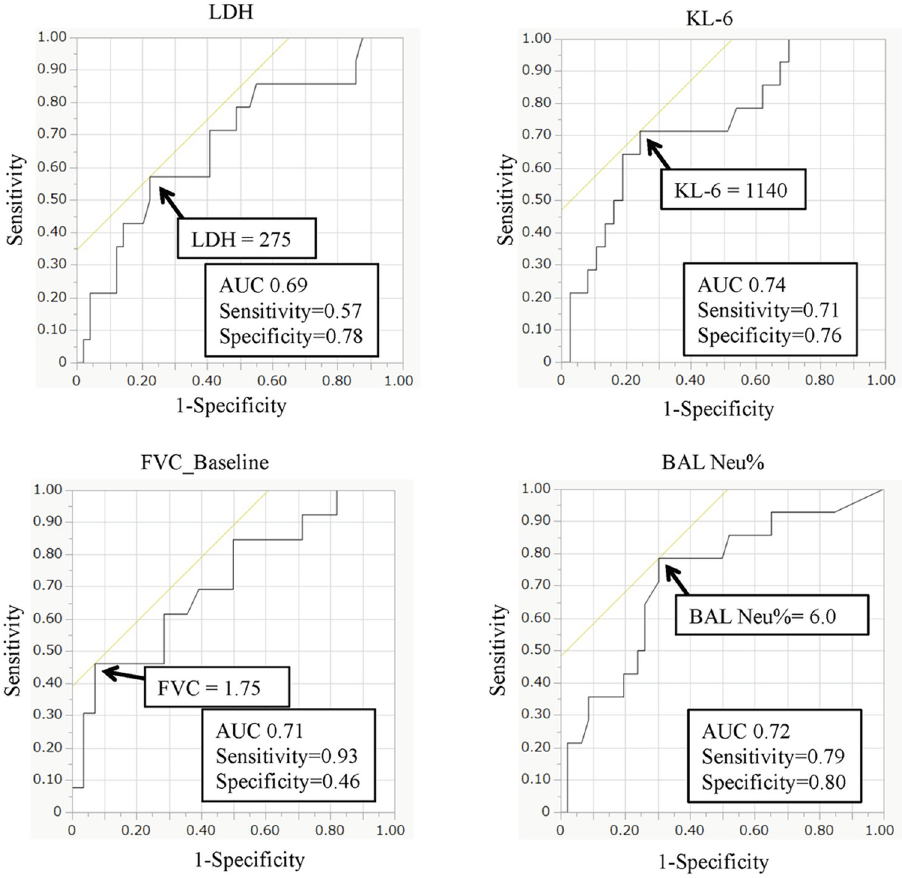
Fig 3. ROC curve analysis of the predictor cut-off values for 3-year mortality. Abbreviations: AUC: area under the ROC curve; ROC: receiver operating characteristic.